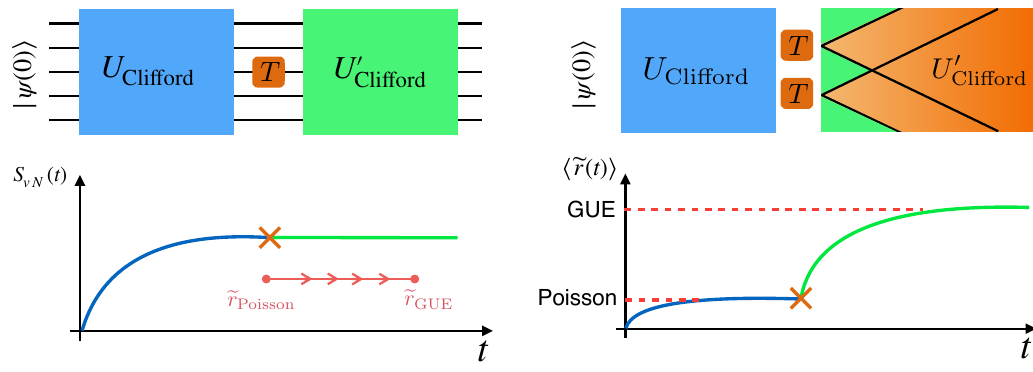
Figure 1: Left : A schematic of the setup considered in this work. Initial product states are first evolved under random Clifford circuits U until their entanglement entropy Cl reaches maximum. Each circuit is constructed with 500 random non-local Clifford gates to maximize the scrambling speed. A certain number of T gates in one layer are then inserted in the circuit, followed by a second stage of random Clifford evolution U (cid:48) also consisting of 500 random non-local Clifford gates. In the thermodynamic Cl limit, the entanglement spectrum approaches a W-D distribution upon inserting a single T gate. Right : A cartoon picture showing the operator spreading of the inserted T gates during the second stage of evolution. Each T gate spreads over a spatial region that grows linearly in time (circuit depth), which sets the timescale for the saturation of the ES statistics to W-D distribution. The onset of W-D statistics occurs when the footprints of the inserted T gates cover all qubits. For this simulation, we choose instead local Clifford gates, so that time is measured in terms of circuit